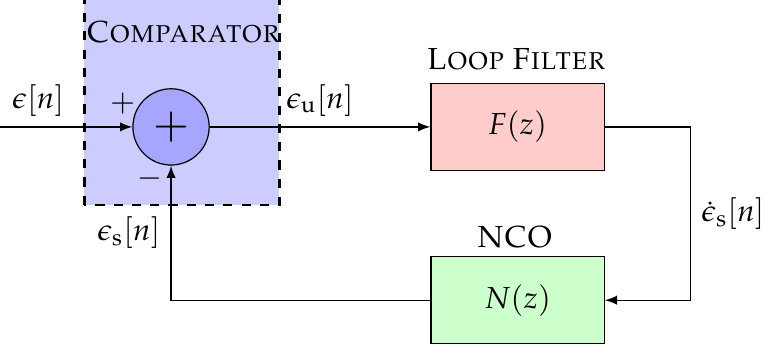
Figure 3. Linear model of the STL. ©IEEE. Adapted, with permission, from